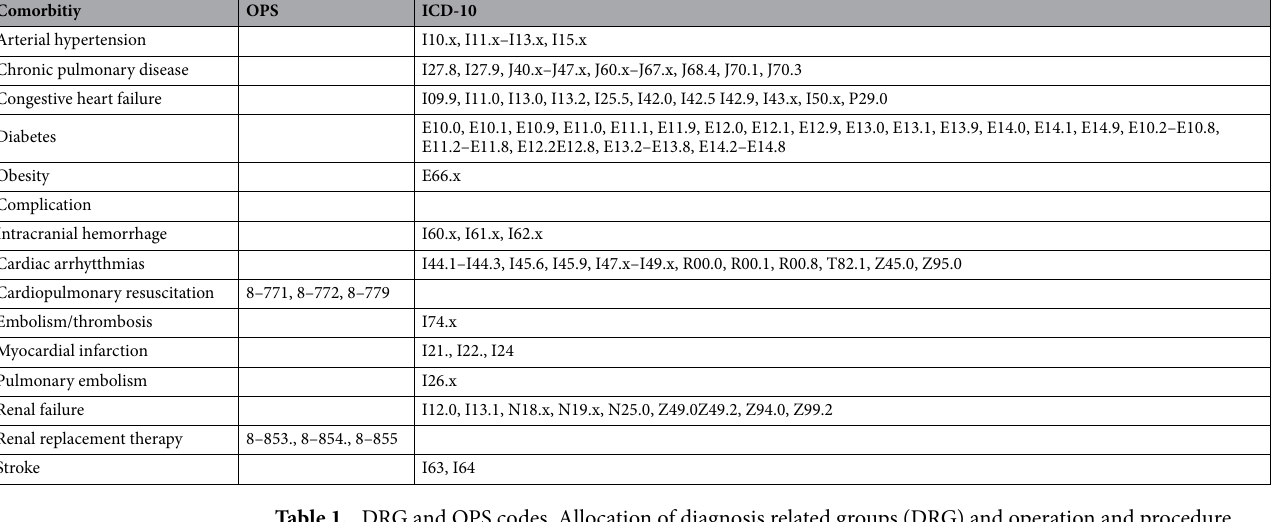
Table 1. DRG and OPS codes. Allocation of diagnosis related groups (DRG) and operation and procedure (OPS) codes as they are coded for reimbursement purposes in